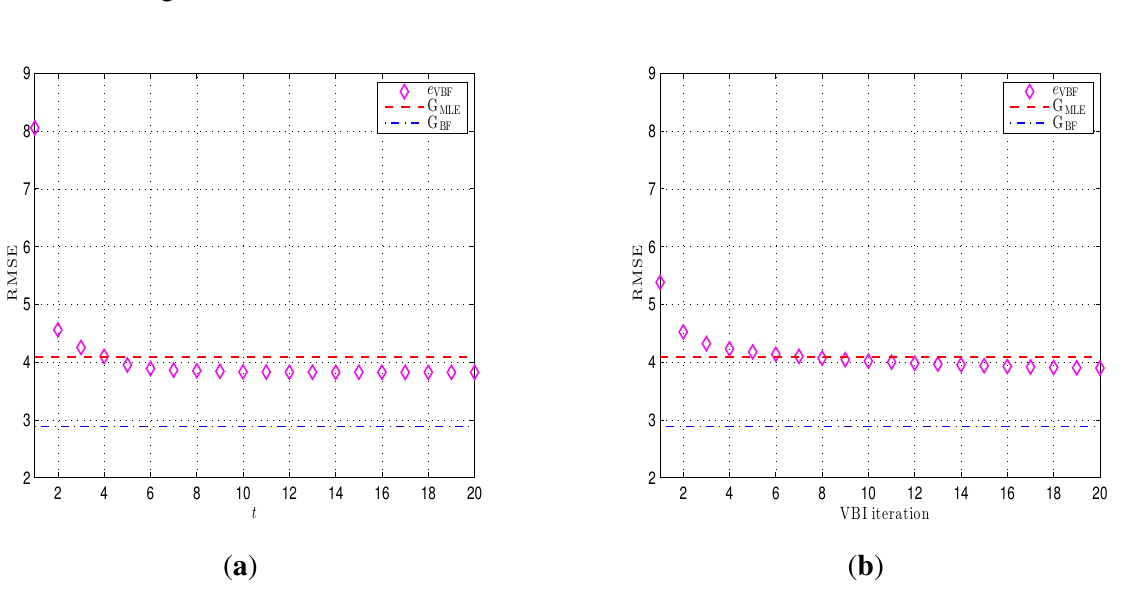
Figure 9. Convergence properties of the VBF scheme. The unit on the y -axis is meters. ( a ) Achieved RMSEs of the VBF algorithm at different time instants; ( b ) achieved RMSEs of the VBI algorithm versus a different iteration number at one time